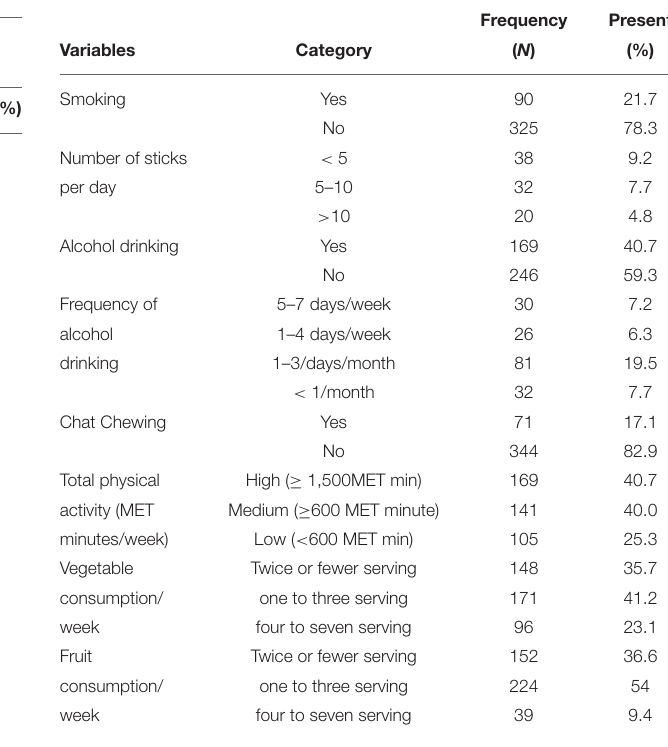
TABLE 2 | Behavioral and lifestyle characteristics of Menja community in South-west, Ethiopia, 2021 ( N =